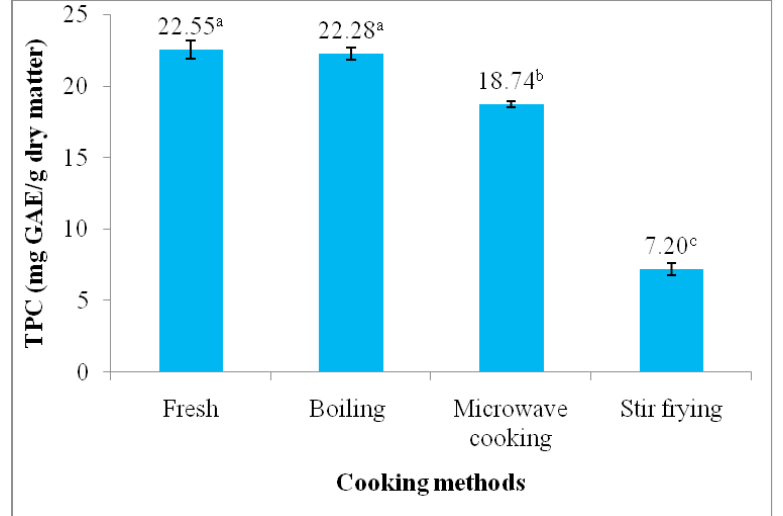
Figure 1: Total phenolic content of fresh and cooked tomato. Data are presented as mean ± standard error. Mean values with different superscripts are significantly different at p< 0.05 by analysis of variance followed by Duncan’s multiple range